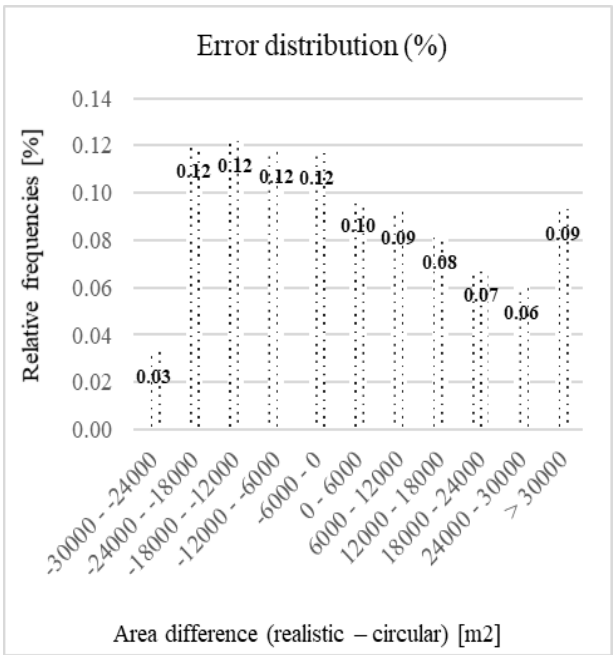
Figure 3. Distribution of the mapping error, defined as the difference for each device between realistic catchment areas and circular